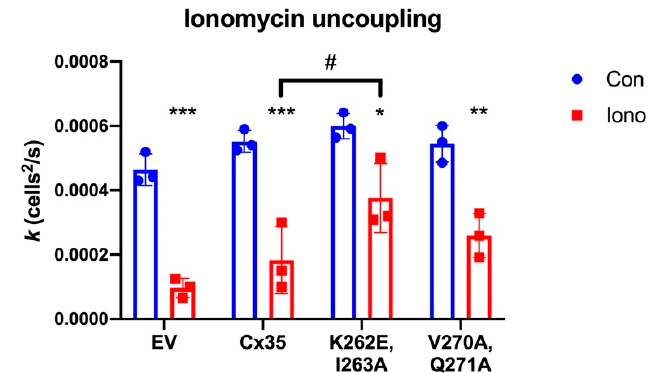
Figure 5. Effects of calmodulin-binding Cx35 mutants on high calcium-induced uncoupling in transiently-transfected HeLa cells. Empty vector transfection (EV) reveals the endogenous tracer coupling in HeLa cells. Ionomycin reduced this background coupling significantly. Ionomycin also reduced coupling in HeLa cells transfected with Cx35 wild type (Cx35) and the mutants K262E, I263A and V270A, Q271A. Bars are mean ± SD, n = 3 experiments; *** p < 0.001, ** p < 0.01 and * p < 0.05 vs. control; # p < 0.05 vs. Cx35 with 5 µM ionomycin.